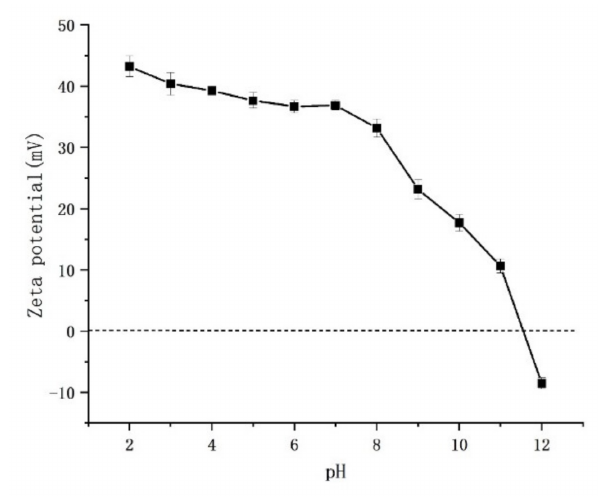
Figure 7. Isoelectric point of Fe 3 O 4 @PDA@PEI.